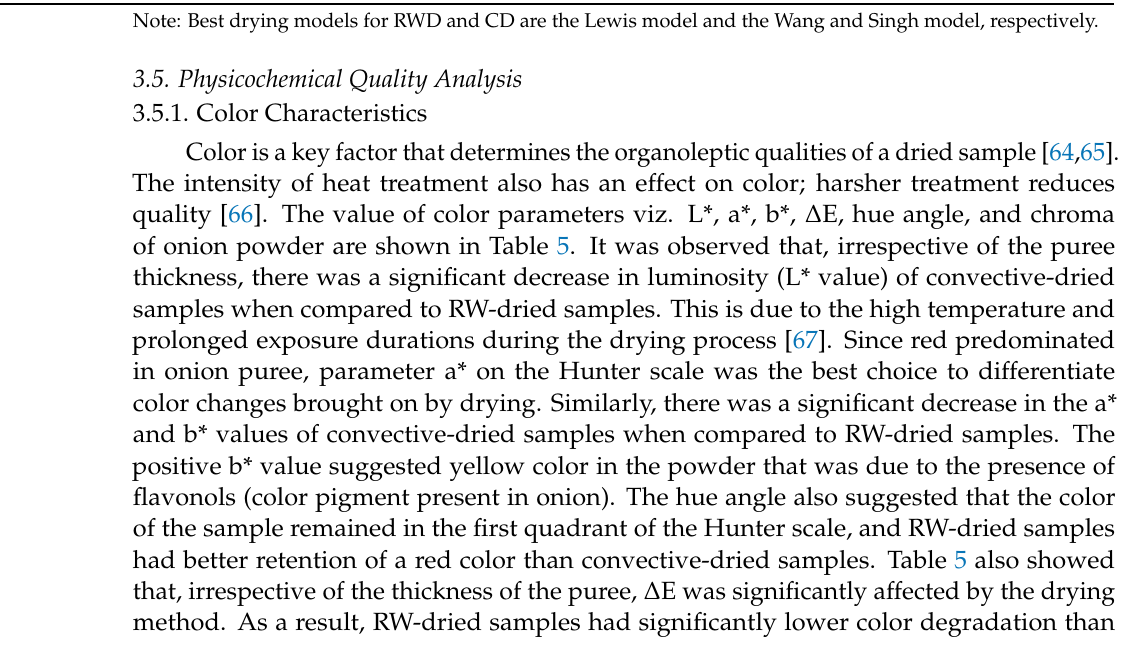
Table 4. R 2 and RMSE values of the best drying model and ANN model.